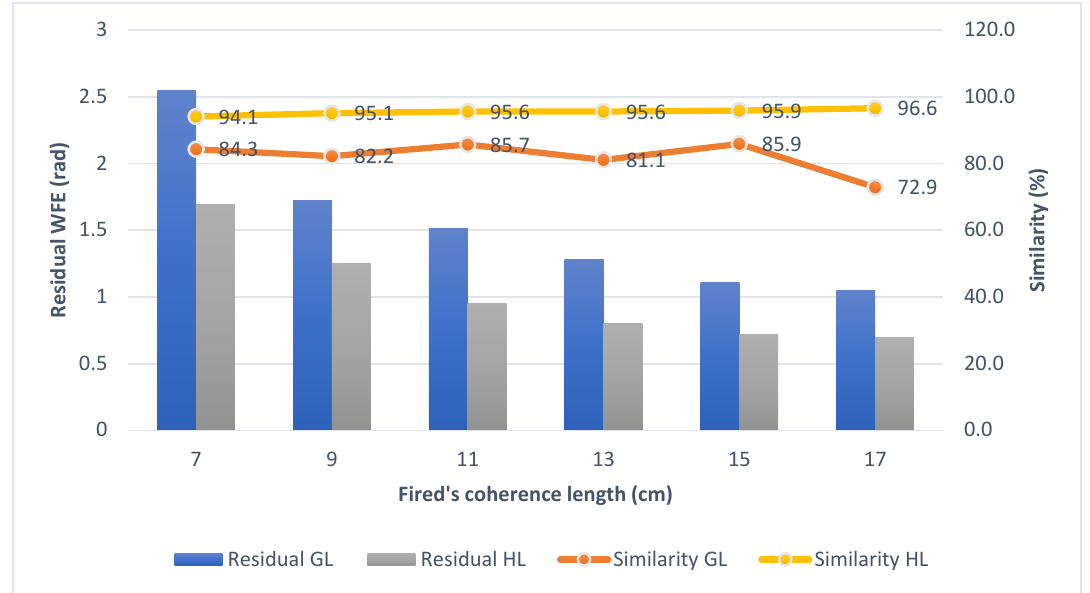
Figure 7. Influence of the height in the reconstructions, using the information received by the sensor as inputs for the FCN for the several 𝑟 0 values tested. To make comprehension easier, the bars for each case are in the same order as the legend and each case has its own markers.